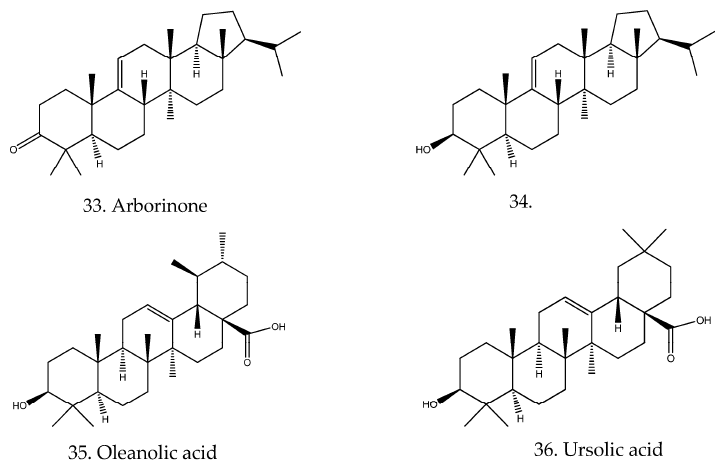
Figure 1. Chemical structures of iridoids and triterpenes in H. diffusa .